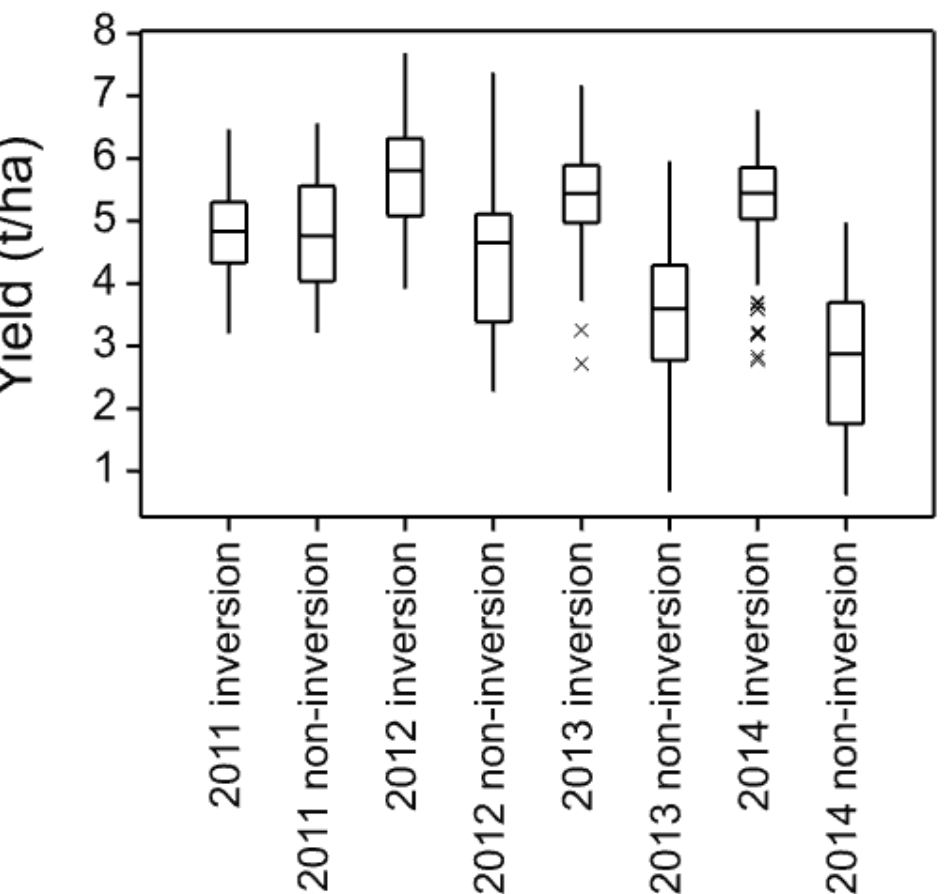
Figure 5. Mean yield of 18 cultivars in inversion and non-inversion tillage from 2011 to 2014.